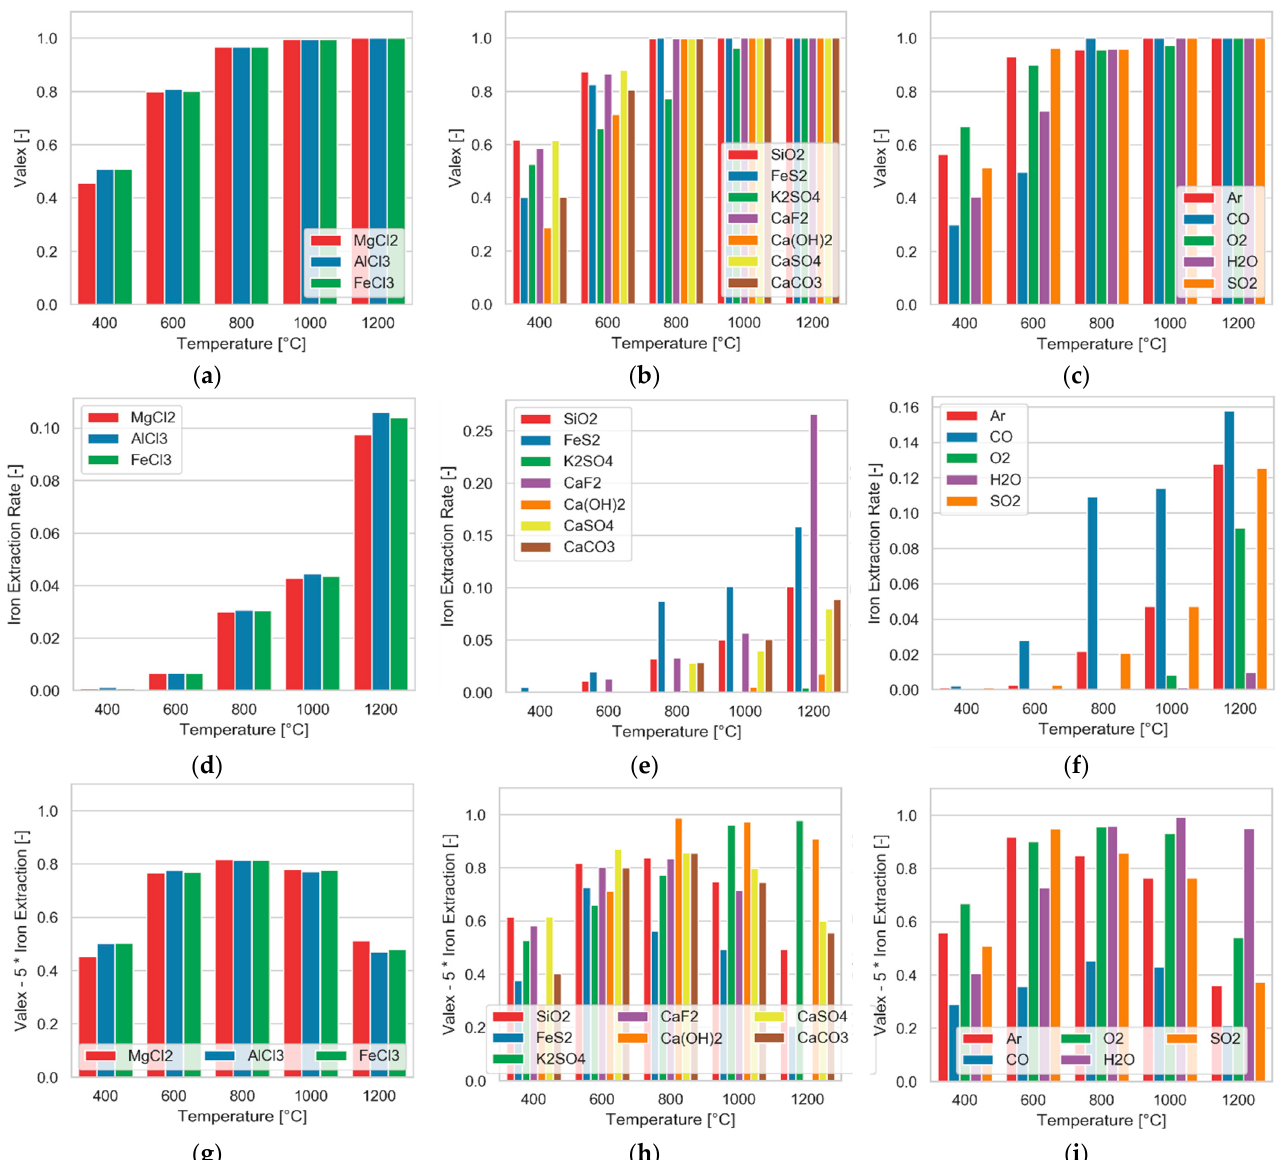
Figure 6. Influence of various SCAs ( a, d, g ), secondary compounds ( b, e, h ), and atmospheres ( c, f, i ) on the extraction rates of valex ( a – c ) and iron ( d – f ) and the difference between both ( g – i ), where iron extraction was weighted 5 ‐ fold, the pressure of 1 atm, and chlorine stoichiometry of 1 .